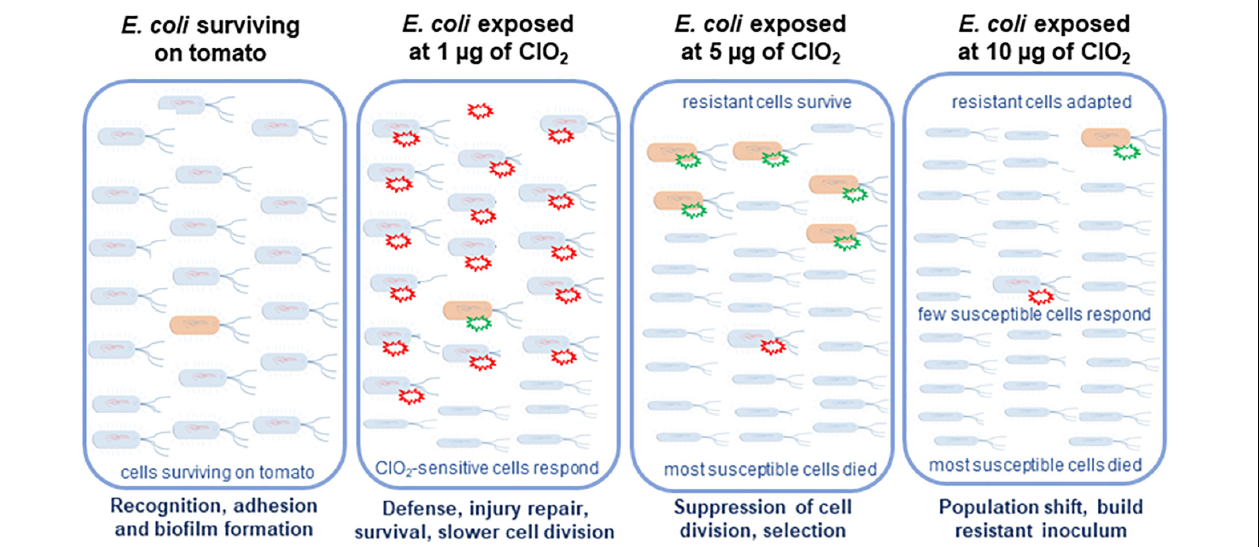
FIGURE 8 | Hypothetical model of the sequential defenses of in E. coli against ClO 2 on its non-host tomato environment. Xenobiotic effects of 1 µ g of ClO 2 resulted in the induction of pathogenesis and stress responses in the majority of the cells which were sensitive. However, 5 µ g of ClO 2 treatment induced massive cell death and selection of several tolerant cells. Under high dose of ClO 2 treatment, which is 10 µ g, with massive cell killing, resistant cells adapted to the environmental